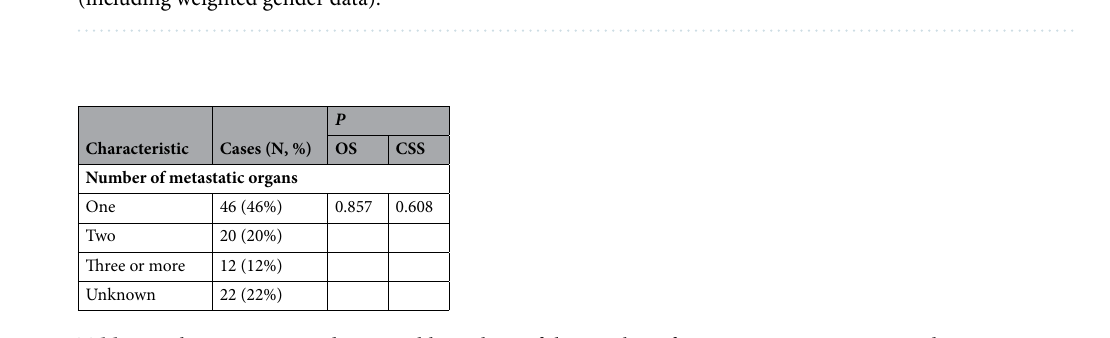
Table 1. Characteristics and univariable analysis of de novo mNPC on OS and CSS in elderly patients (including weighted gender data).